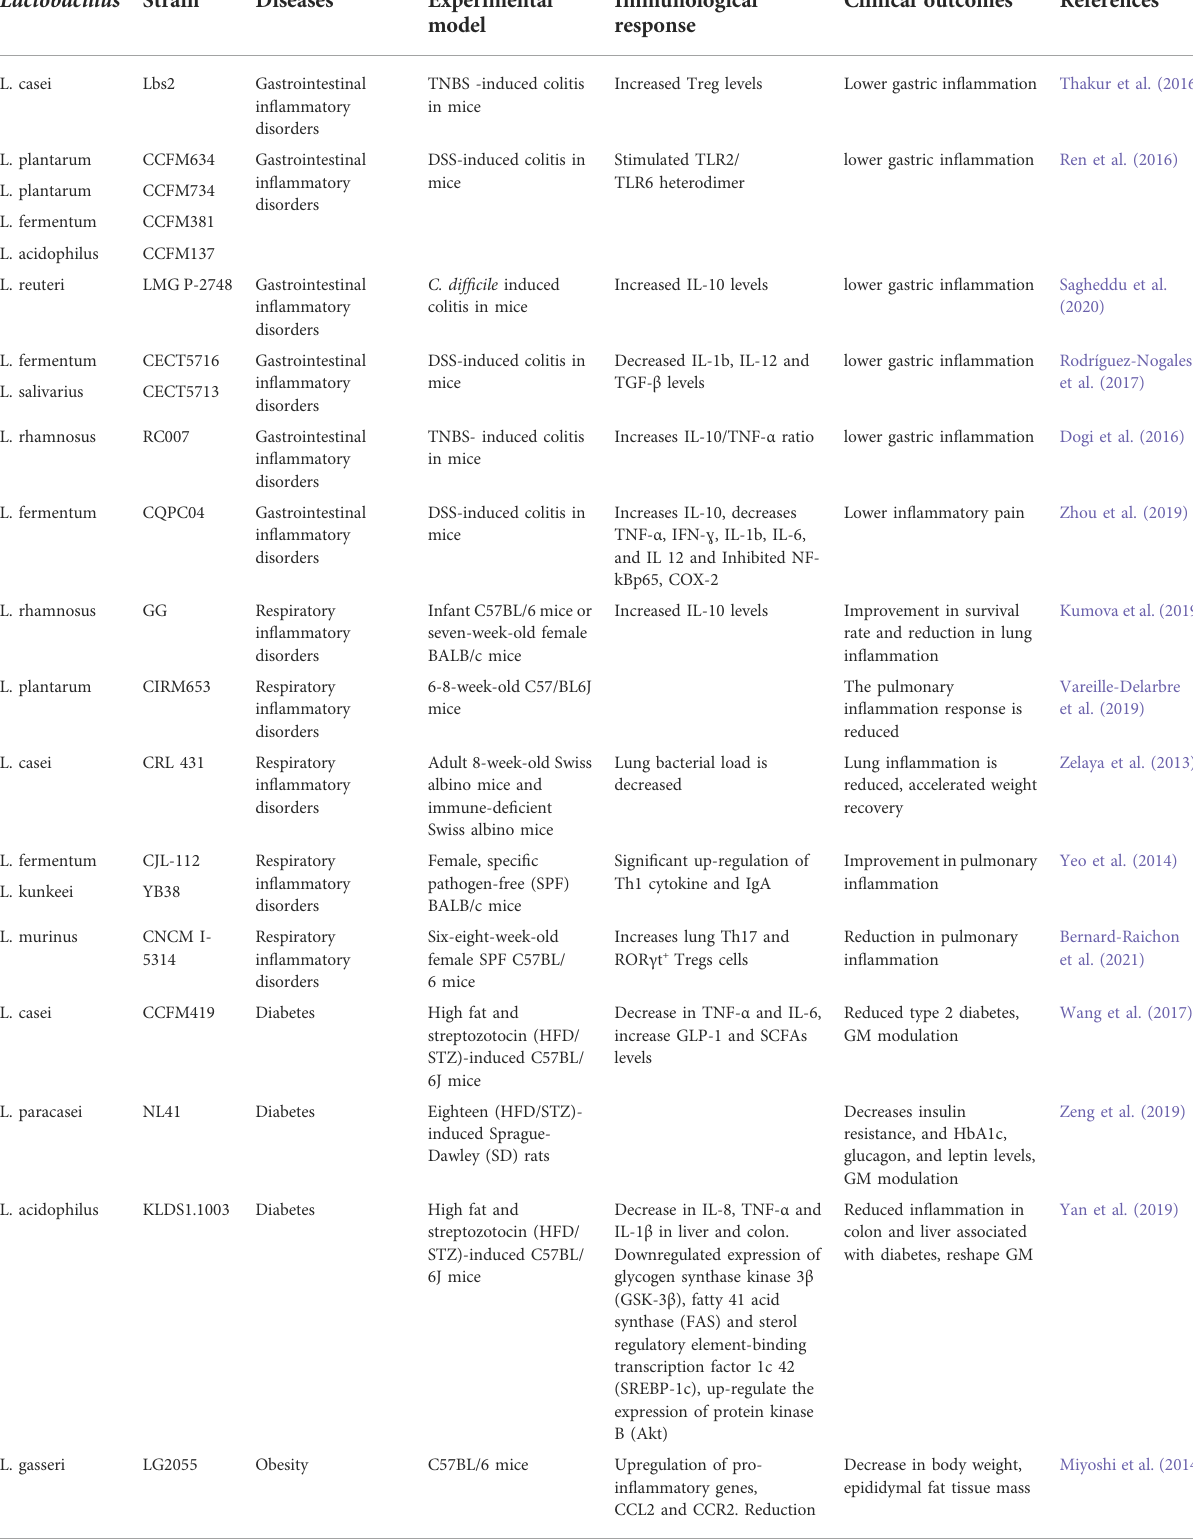
TABLE 1 Animal and clinical studies of different Lactobacillus strains in alleviating in fl ammatory diseases pertaining to different